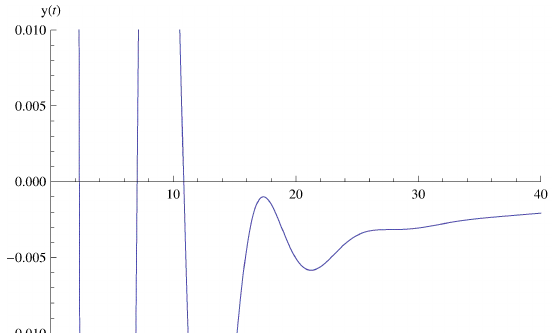
Fig. 10. The function y.t/ for b D 1;c D 1 and ˛ D